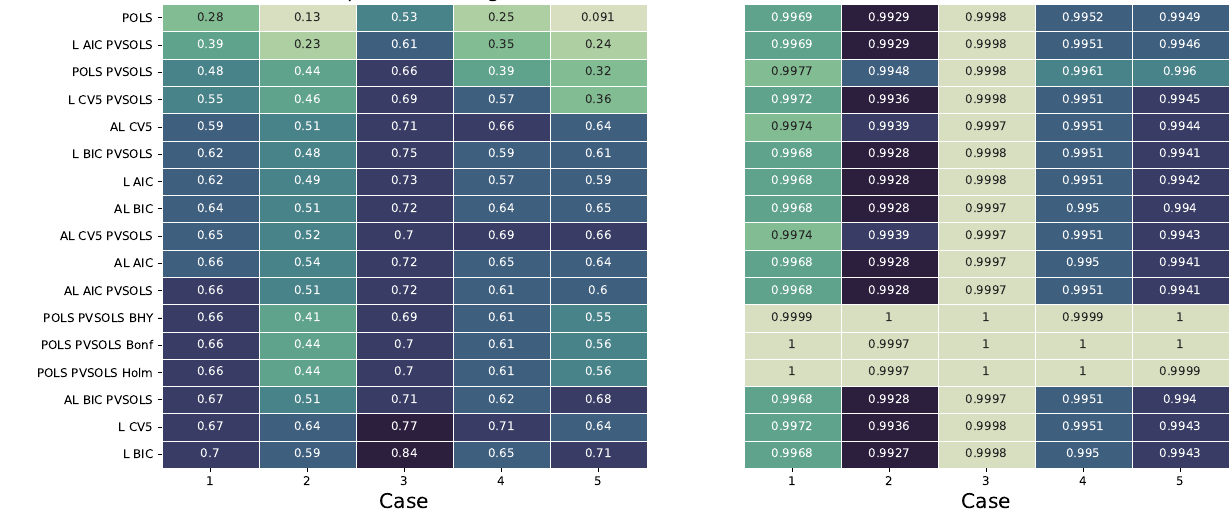
Figure 2. The figure shows the simulated out-of-sample prediction evaluation for each method. Pooled OLS (POLS), Lasso AIC with post-variable selection OLS (L AIC PVOLS), pooled OLS with post-variable selection OLS (POLS PVOLS), Lasso CV5 with post-variable selection OLS (L CV5 PVOLS), adaptive Lasso CV5 (AL CV5), Lasso BIC with post-variable selection OLS (L BIC PVOLS), Lasso AIC (L AIC), adaptive Lasso BIC (AL BIC), adaptive Lasso CV5 with post-variable selection OLS (AL CV5 PVOLS), adaptive Lasso AIC (AL AIC), adaptive Lasso AIC with post-variable selection OLS (AL AIC PVOLS), pooled OLS with post-variable selection OLS and the BHY t-value adjustment(POLS PVOLS BHY), pooled OLS with post-variable selection OLS and the Bonferroni t-value adjustment (POLS PVOLS Bonf), pooled OLS with post-variable selection OLS and the Holm t-value adjustment(POLS PVOLS Holm), adaptive Lasso BIC with post-variable selection OLS (AL BIC PVOLS), Lasso CV5 (L CV5) and Lasso BIC (L BIC). The plot on the left side shows average MCS p-values over all 2000 simulation cases, where the p-value measures if the model is part of the MCS. The right figure illustrates the MSE values relative to the max of each case. The darker the color the better the performance relative to the competing